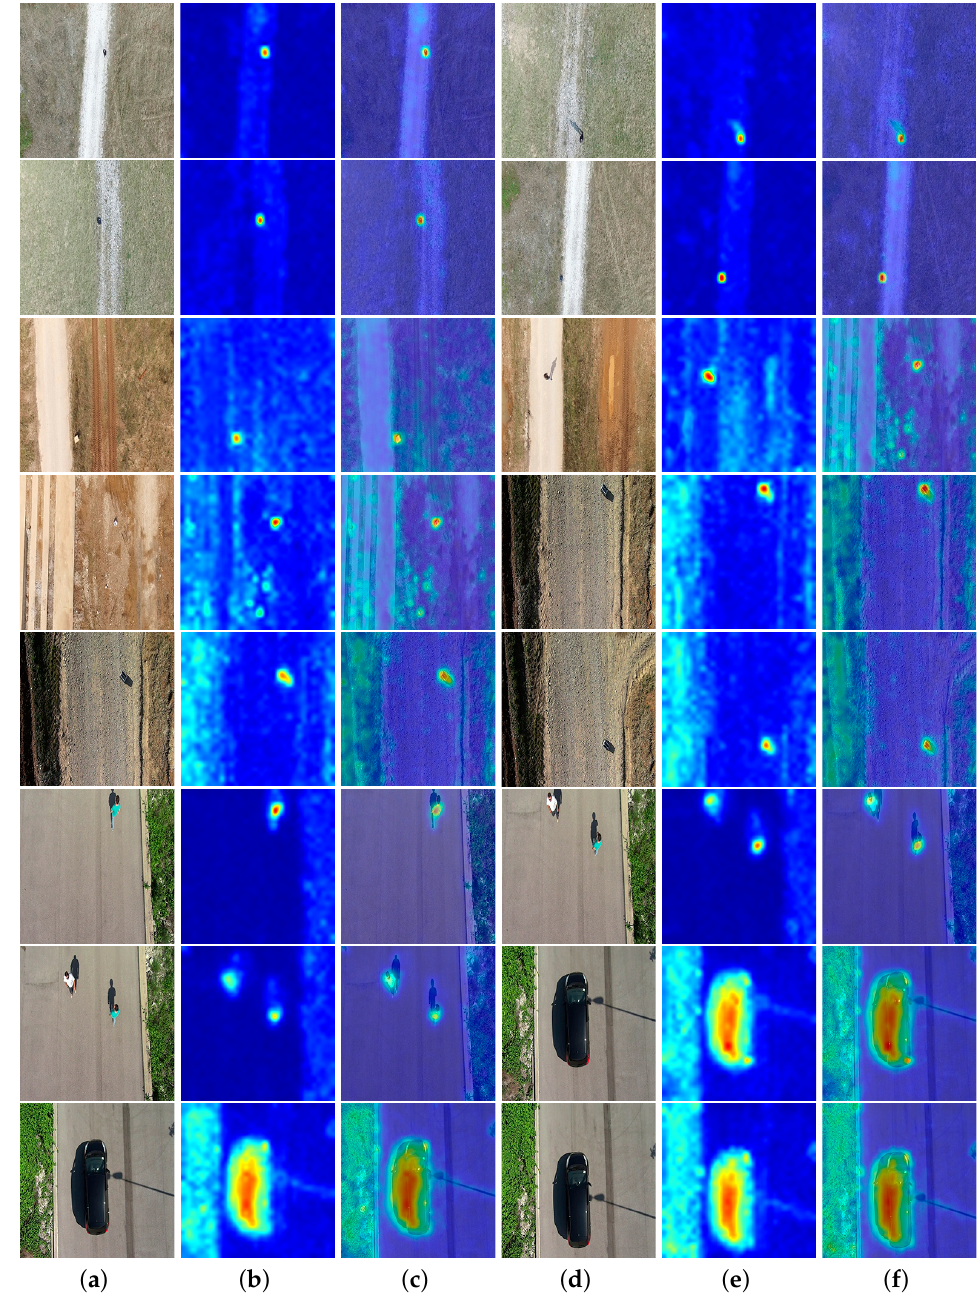
Figure 7. Examples of M ( b , e ) and resulting localization ( c , f ) computed on images ( a , d ) with different abnormal elements in multiple